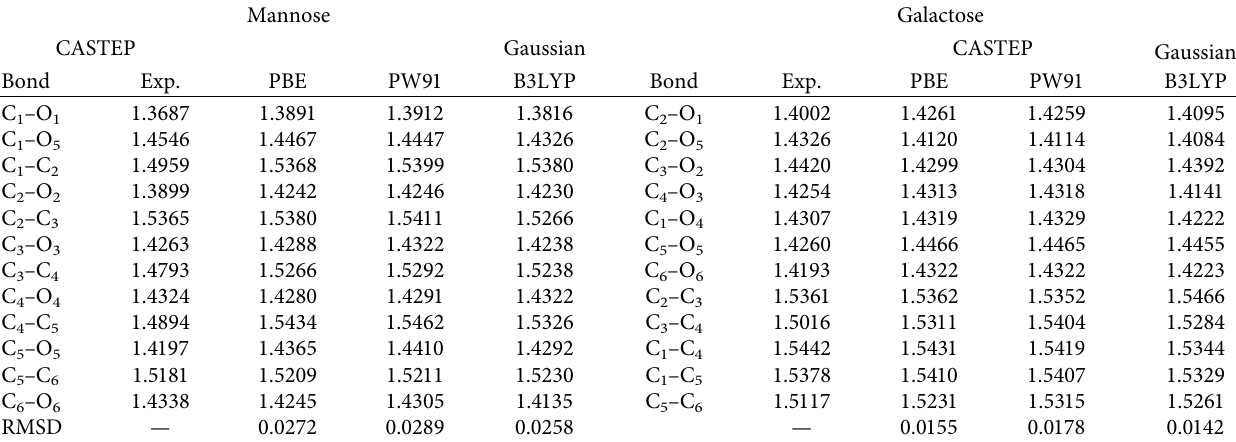
Table 1: Calculated bond lengths (˚A) and RMSD values of mannose and galactose compared to experimental X-ray values a .